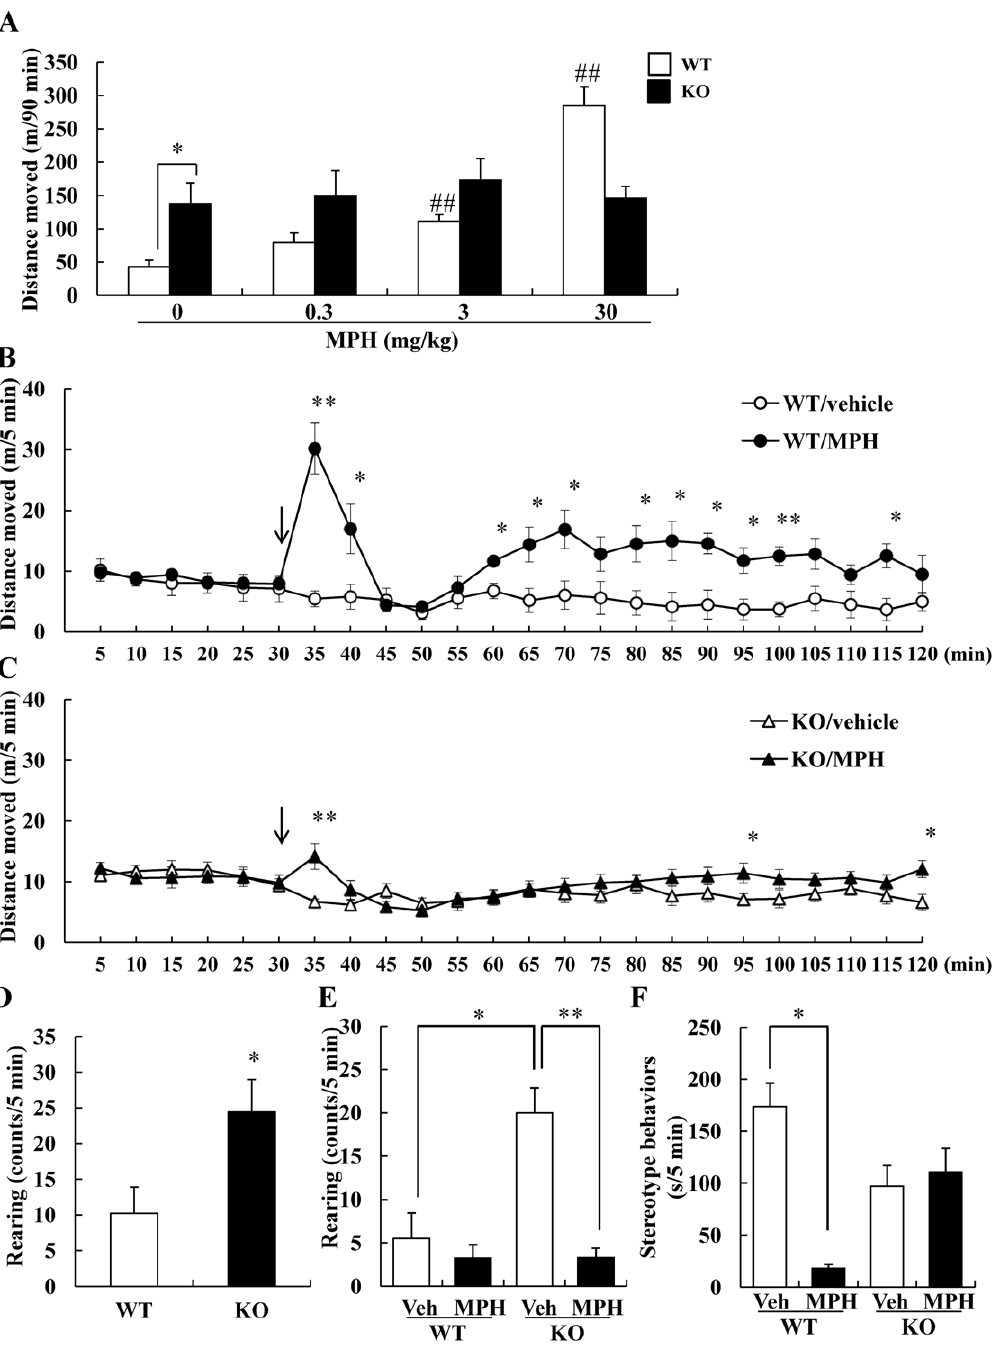
Figure 2. DGK b KO mice showed an abnormal response to methylphenidate. (A) The locomotor activity after various doses of MPH. Each mouse was placed in a locomotor activity monitor for an initial period of 30 min and then injected with vehicle or MPH (0.3, 3, 30 mg/kg, i.p.). Horizontal activities of 90 min after drug treatment were recorded. Values are expressed as the mean 6 S.E.M. (n=5) *; p , 0.05 vs. vehicle-treated WT mice ( t -test), # ; p , 0.05, ## ; p , 0.01 vs. vehicle-treated WT mice (Dunnett’s test). Each mouse was placed in a locomotor activity monitor for an initial period of 30 min (shown as arrow) and then injected with vehicle or MPH (30 mg/kg). Horizontal activity was recorded every 5 min for a 2-h period. Locomotor activity throughout the 2-h period of WT (B) and DGK b KO (C) mice. Values are expressed as the mean 6 S.E.M. (n=4 to 10) *; p , 0.05, **; p , 0.01 vs. vehicle-treated group ( t -test). (D) Rearing behavior of WT and DGK b KO mice in the first 5 min of open field test. Values are expressed as the mean 6 S.E.M. (n=5, 7) *; p , 0.05 vs. WT mice ( t -test). (E) Rearing behavior of MPH/vehicle treated WT and KO mice for 5 min after drug treatment. Values are expressed as the mean 6 S.E.M. (n=4 to 10) *; p , 0.05, **; p , 0.01 vs. vehicle-treated KO mice group ( t -test). (F) The duration of the stereotyped behaviors for 5 min after drug treatment. Values are expressed as the mean 6 S.E.M. (n=4 to 10) *; p , 0.05, **; p , 0.01 vs. vehicle-treated WT mice group ( t -test).